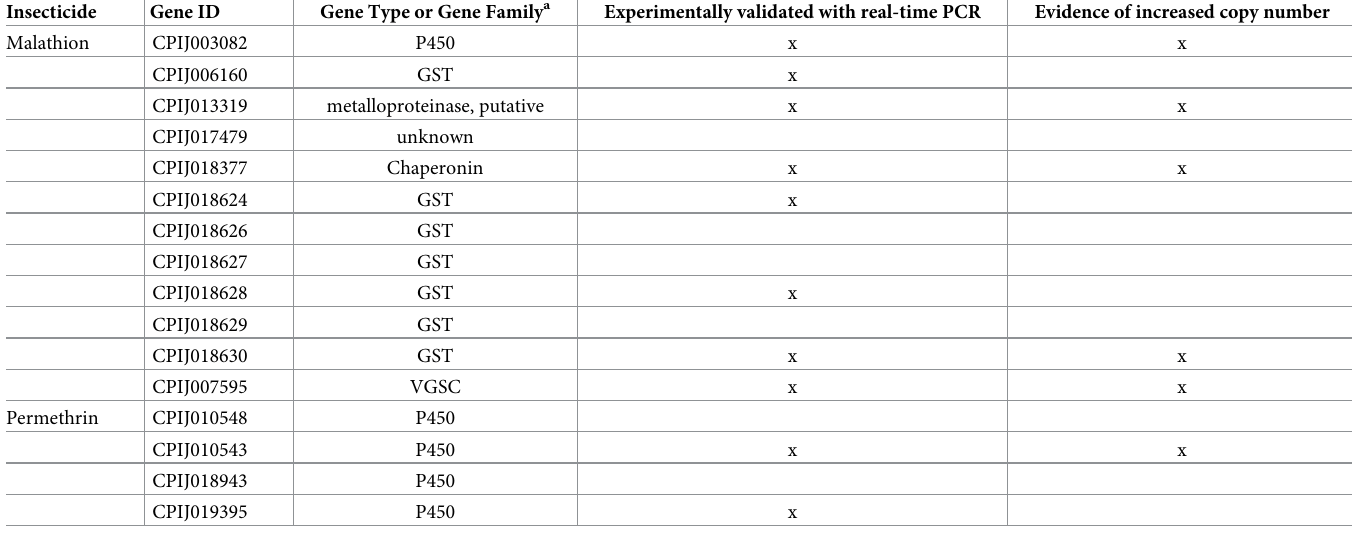
Table 4. CoNIFER results showing genes (by insecticide) present in greater copy numbers (T-test p-value � 0.05) in resistant vs. susceptible individuals. Insecticide Gene Type or Gene Family a Experimentally validated with real-time PCR Evidence of increased copy